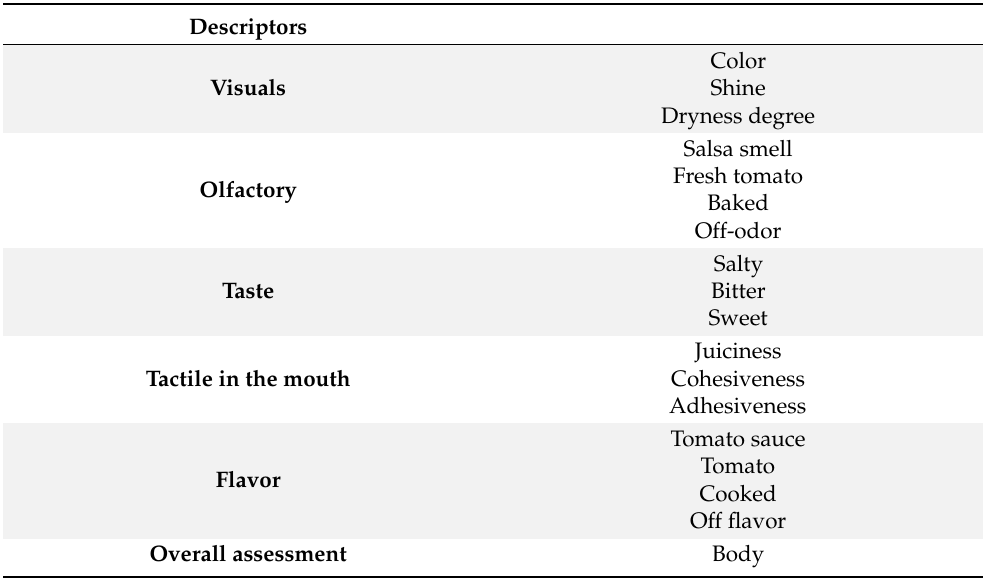
Table 1. Descriptors found for the sensory